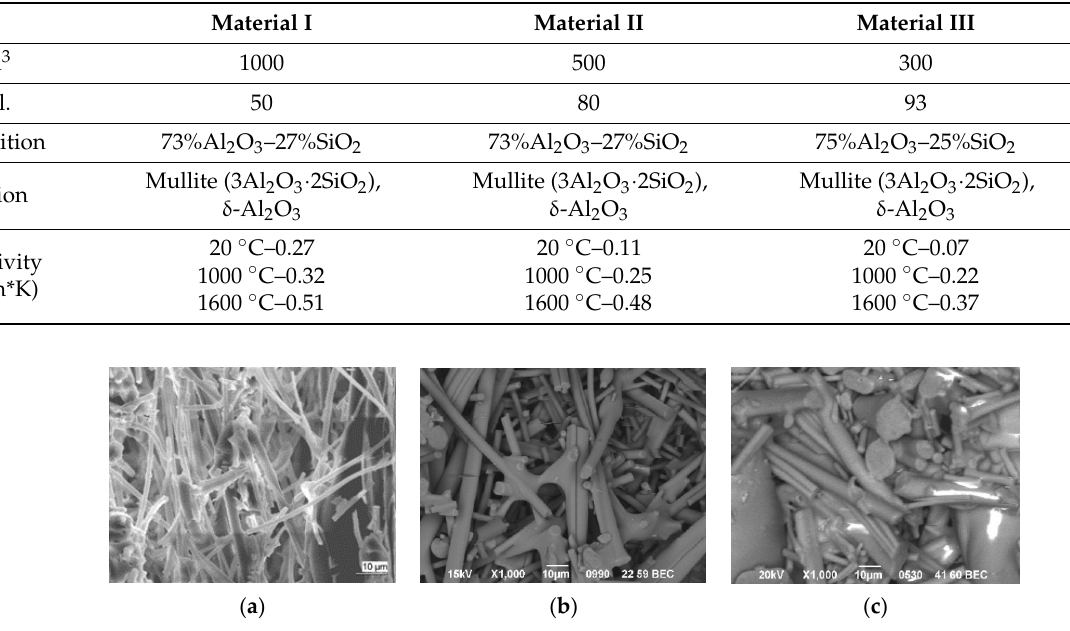
Figure 1. The microstructure of fibrous ceramic materials: ( a ) The material I; ( b ) The material II; ( c ) The material III.